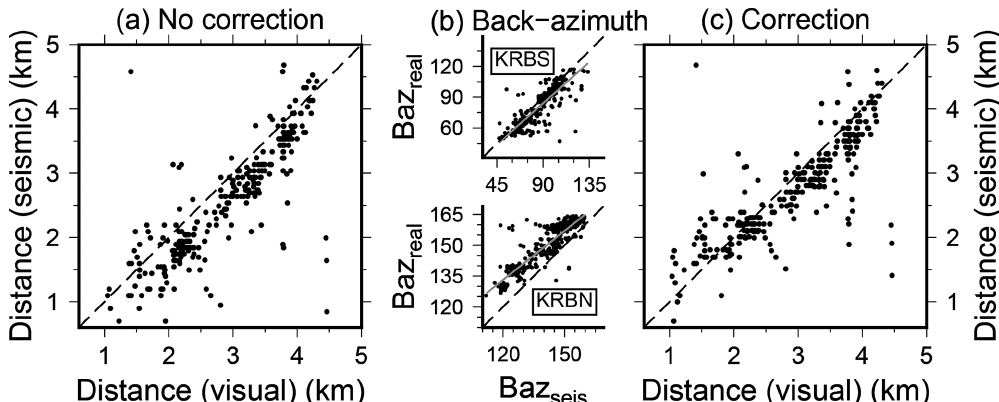
Figure D1. Distances from the southern end of the terminus for calving events located from seismic signals and visually observed on time- lapse camera images. (a) No correction. (b) Back-azimuth (degrees from north) of calving signals observed on both seismic arrays vs. visually observed. Gray line shows results of a linear regression. (c) Same as in (a) but applying an empirical correction based on the regression in (b) correcting for observed back-azimuth